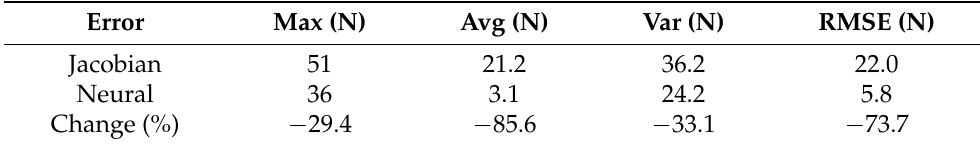
Table 4. Statistical value of prove test in CAD model.